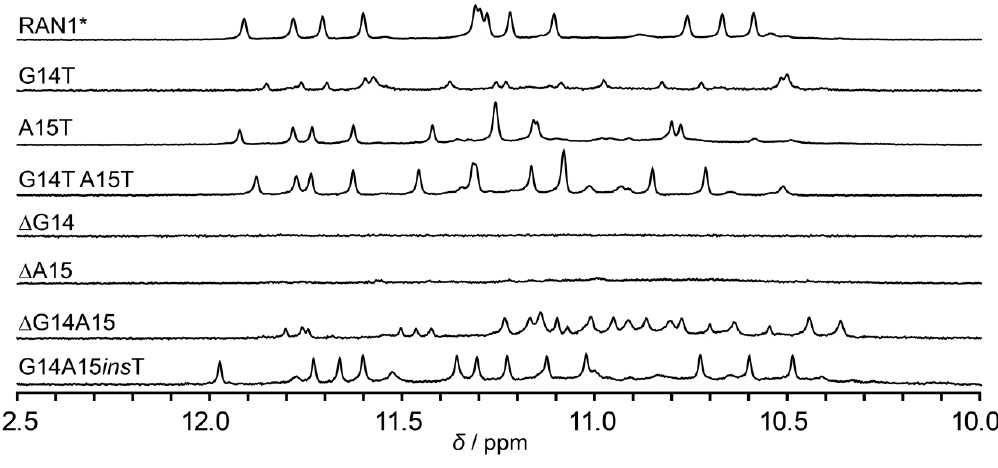
Figure 4. Imino regions of RAN1* and its modified sequences.